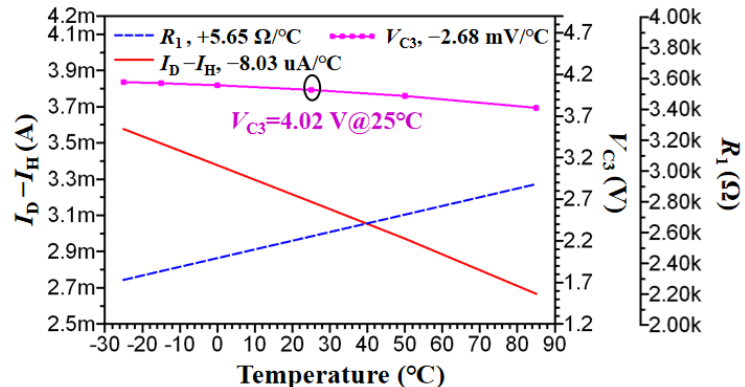
Figure 7. Simulated R 1 , I D , I H and V C3 over temperature.